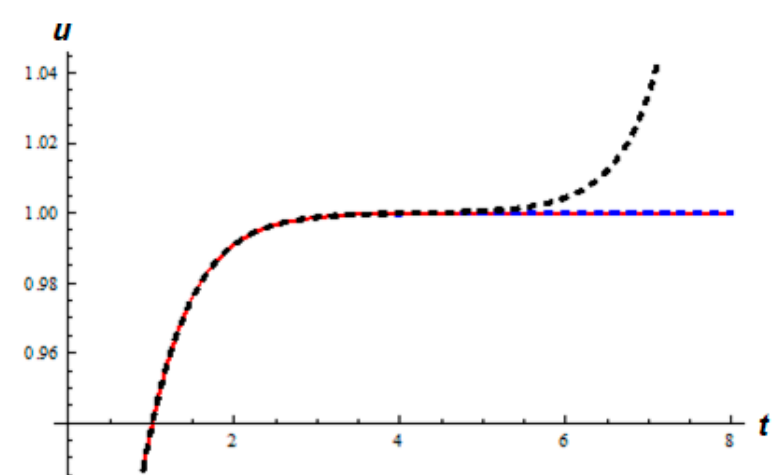
Figure 1. Plots of the exact solution (blue dashed line, see Equation (20)) versus approximate analytic solution (red solid line, see Equation (21) for n = 10) and RK4 method (black dashed line) using the MDM for 0 ≤ t ≤ 8 and h = 0.1. Mathematics 2019 , 7 , x 8 of 14